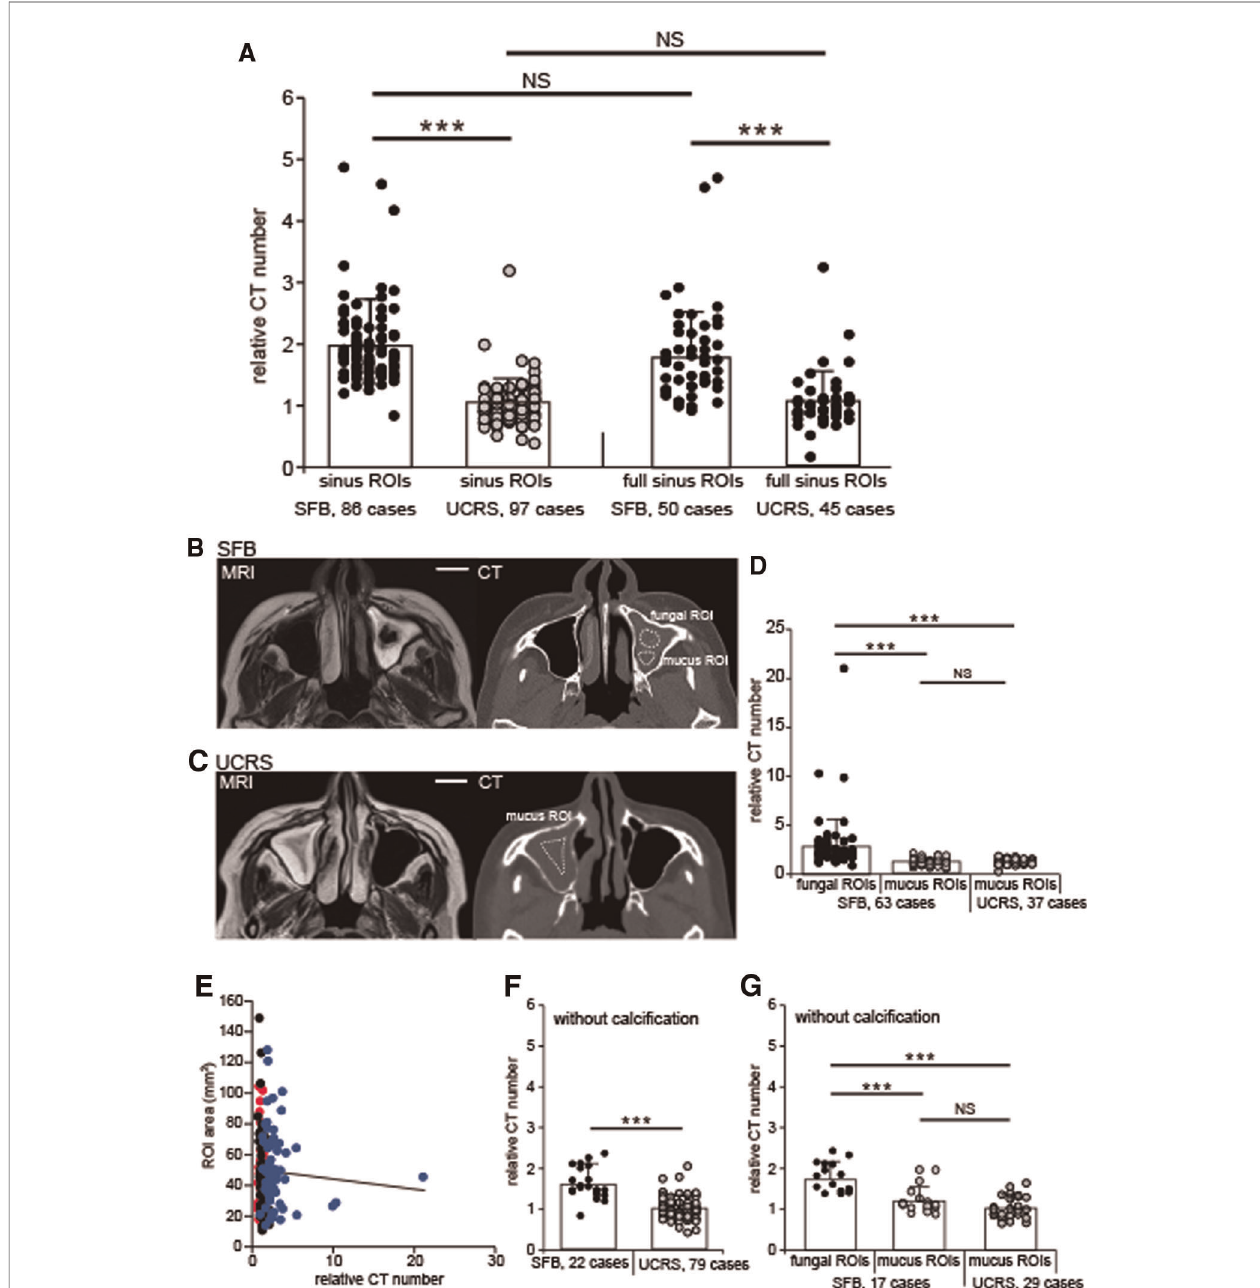
FIGURE 2 | Relative CT numbers of SFB and UCRS cases, ( A ) Relative CT numbers in the sinus and the full sinus ROIs of SFB and UCRS. Each dot represents the relative CT number of an individual SFB or UCRS. All values are mean±SD. *** p <0.001; NS, not signi fi cant; Mann – Whitney U test. ( B ) CT and MRI images of an SFB case. The fungal ROIs were de fi ned as areas with low intensity on T2-weighted images, and were drawn directly on the CT image using the MRI scans as a reference. The mucus ROIs were de fi ned as the sinus ROIs excluding the area with low intensity on T2-weighted images. ROI, region of interest. Scale bar, 20 mm. ( C ) CT and MRI images of an UCRS case. The mucus ROIs were de fi ned as the sinus ROIs excluding the area with high intensity (mucosal thickening region) on T2-weighted images. ROI, region of interest. Scale bar, 20 mm. ( D ) Relative CT numbers in fungal and mucus ROIs. Each dot represents the relative CT number of an individual fungal or mucus ROI in SFBs (63 cases) or mucus ROI in UCRSs (37 cases). All values are mean±SD. *** p <0.001, Steel-Dwass test. NS, not signi fi cant. ( E ) Correlation between the ROI area and the relative CT numbers. Red, mucus ROIs (UCRS); blue, mucus ROIs (SFB); black, fungal ROIs. ( F ) Relative CT numbers in SFB and UCRS without calci fi cation. Each dot represents the relative CT number of an individual SFB (22 cases) or UCRS (79 cases) without calci fi cation. All values are mean±SD. Mann – Whitney U test. NS, not signi fi cant. ( G ) Relative CT numbers in fungal and mucus ROIs without calci fi cation. Each dot represents the relative CT number of an individual fungal or mucus ROI in SFBs (17 cases) or mucus ROI in UCRSs (29 cases) without calci fi cation. All values are mean±SD. *** p <0.001, Steel-Dwass test. NS, not signi fi cant.